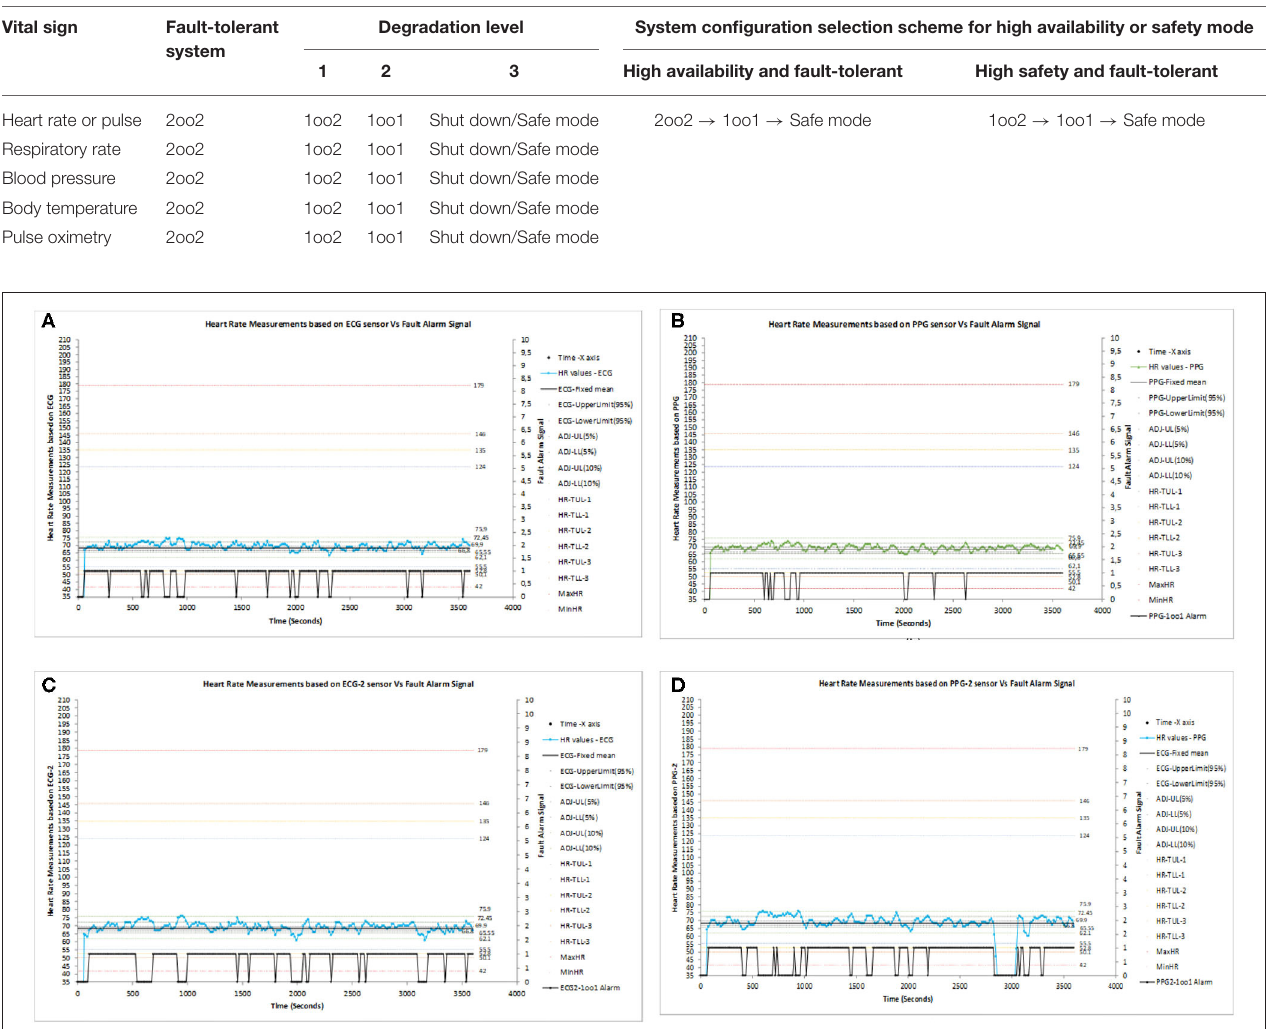
FIGURE 6 | (A) Heart rate (HR) measurement based on the ECG sensor vs. the fault alarm signal in 1oo1 configuration. (B) HR measurement based on the PPG sensor vs. the fault alarm signal in 1oo1 configuration. (C) HR Measurement based on the ECG-2 sensor vs. the fault alarm signal in 1oo1 configuration. (D) HR Measurement based on the PPG-2 sensor vs. the fault alarm signal in 1oo1 configuration.